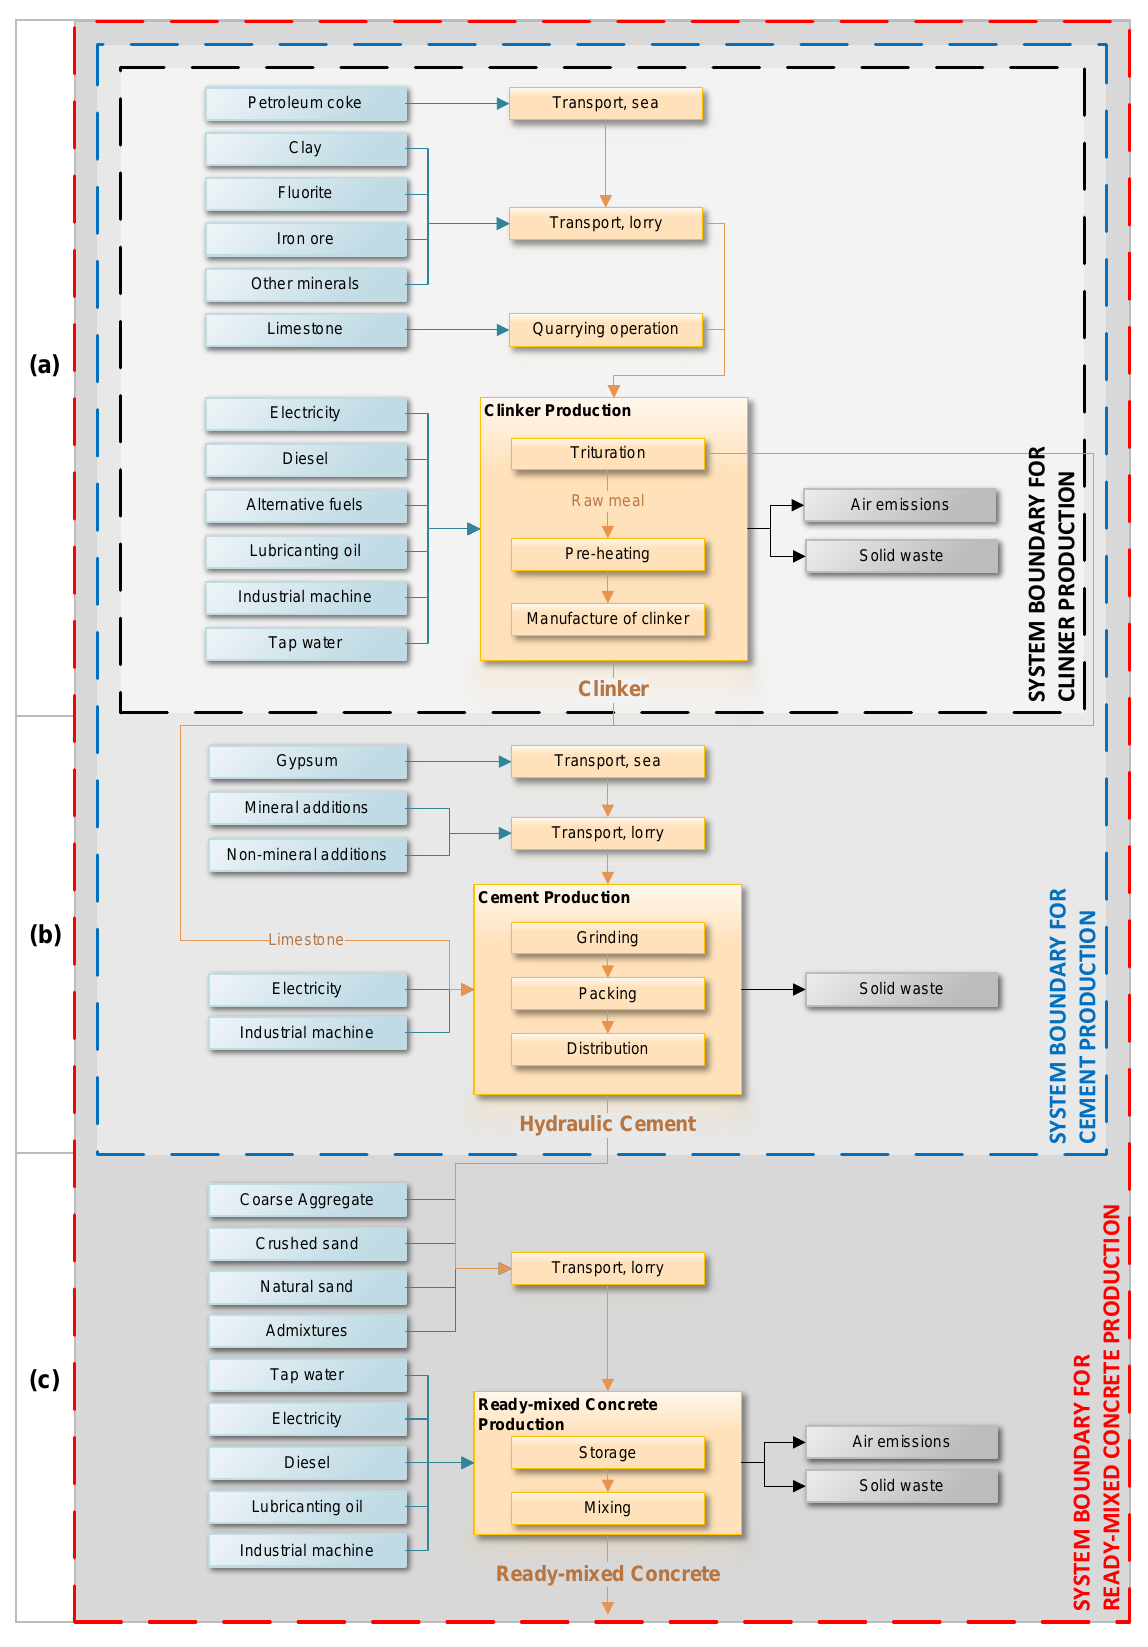
Figure 1. Cradle-to-gate system boundaries for the production of clinker, cement, and concrete in Ecuador: Ecuador: ( a ) clinker production, ( b ) cement production, and ( c ) ready-mixed concrete